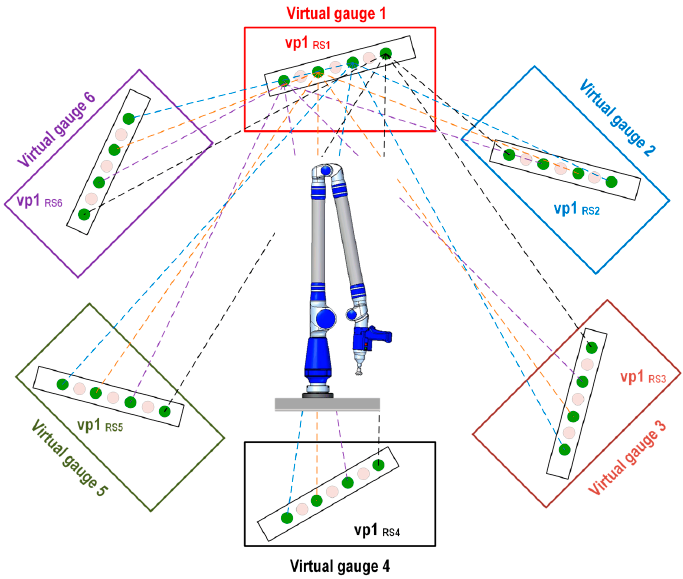
Figure 8. Evaluation method 3: crossed virtual distances between virtual gauge 1 and virtual gauges (2–6).